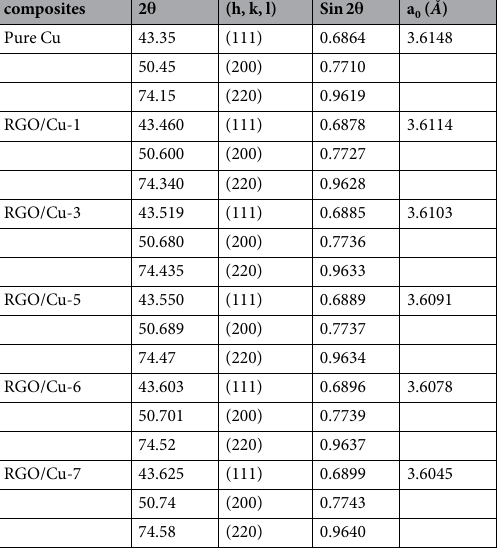
Table 1. The lattice parameter calculated from XRD for RGO/Cu composites and pure Cu